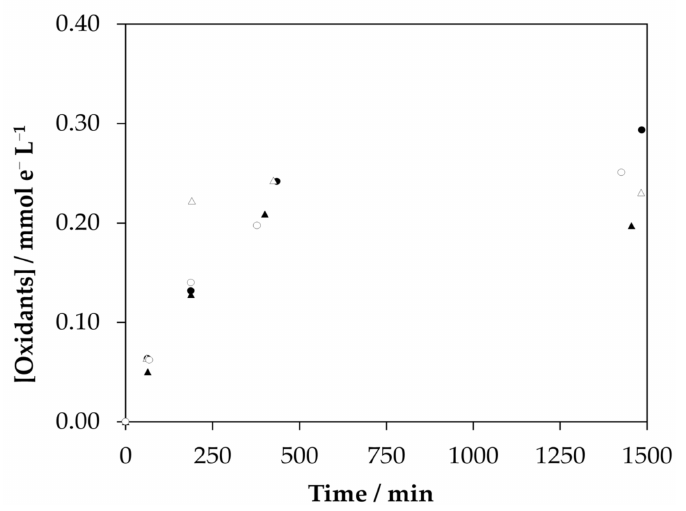
Figure 6. Concentration of total oxidants in the gas phase. Test 1 ( • ), test 2 ( ∆ ), test 3 ( (cid:78) ) and test 4 (